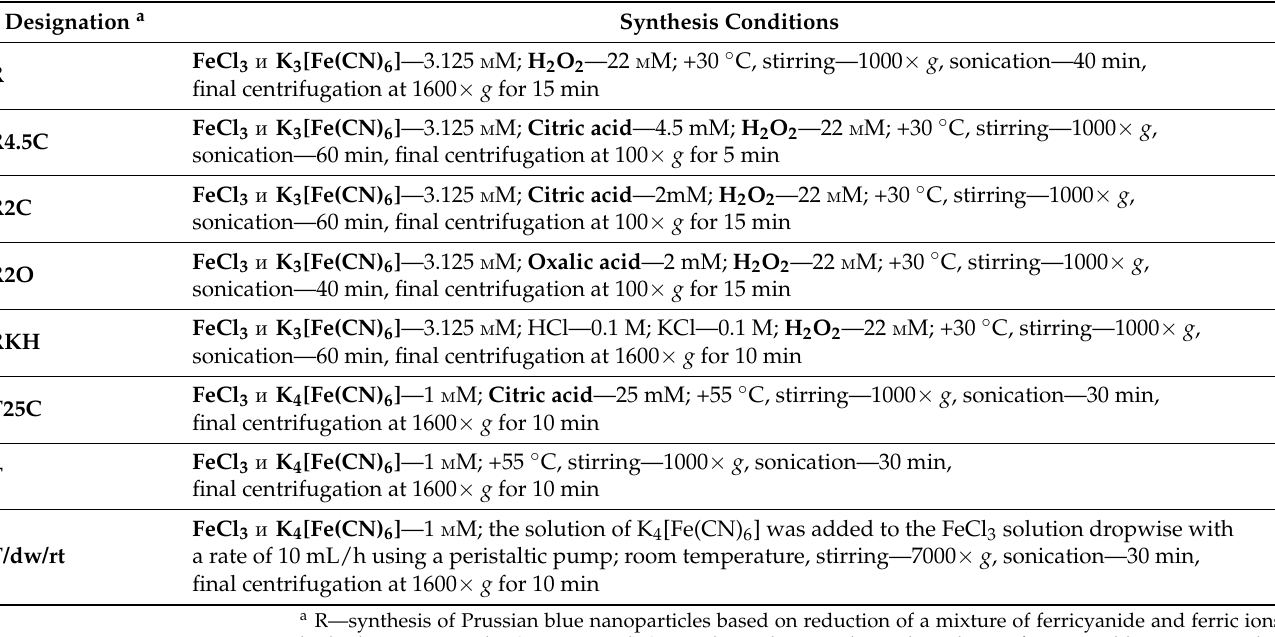
Table 1. Details of Prussian blue nanoparticle synthesis (scale-up